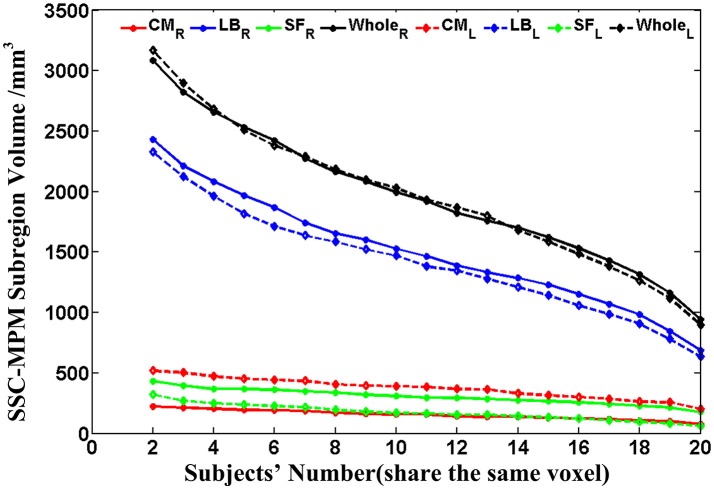
The volume variation of the whole amygdala and each subregion within the SSC-MPM with the change of the subjects' number that share the same voxel. The dotted and solid lines represent the left and right hemispheres, respectively. The volume of the whole amygdala and the CM, LB, as well as the SF subregion in the SSC-MPM was shown separately. SSC-MPM, semi-supervised clustering parcellation maximum probability map; CM, centromedial; LB, laterobasal; SF, superficial.